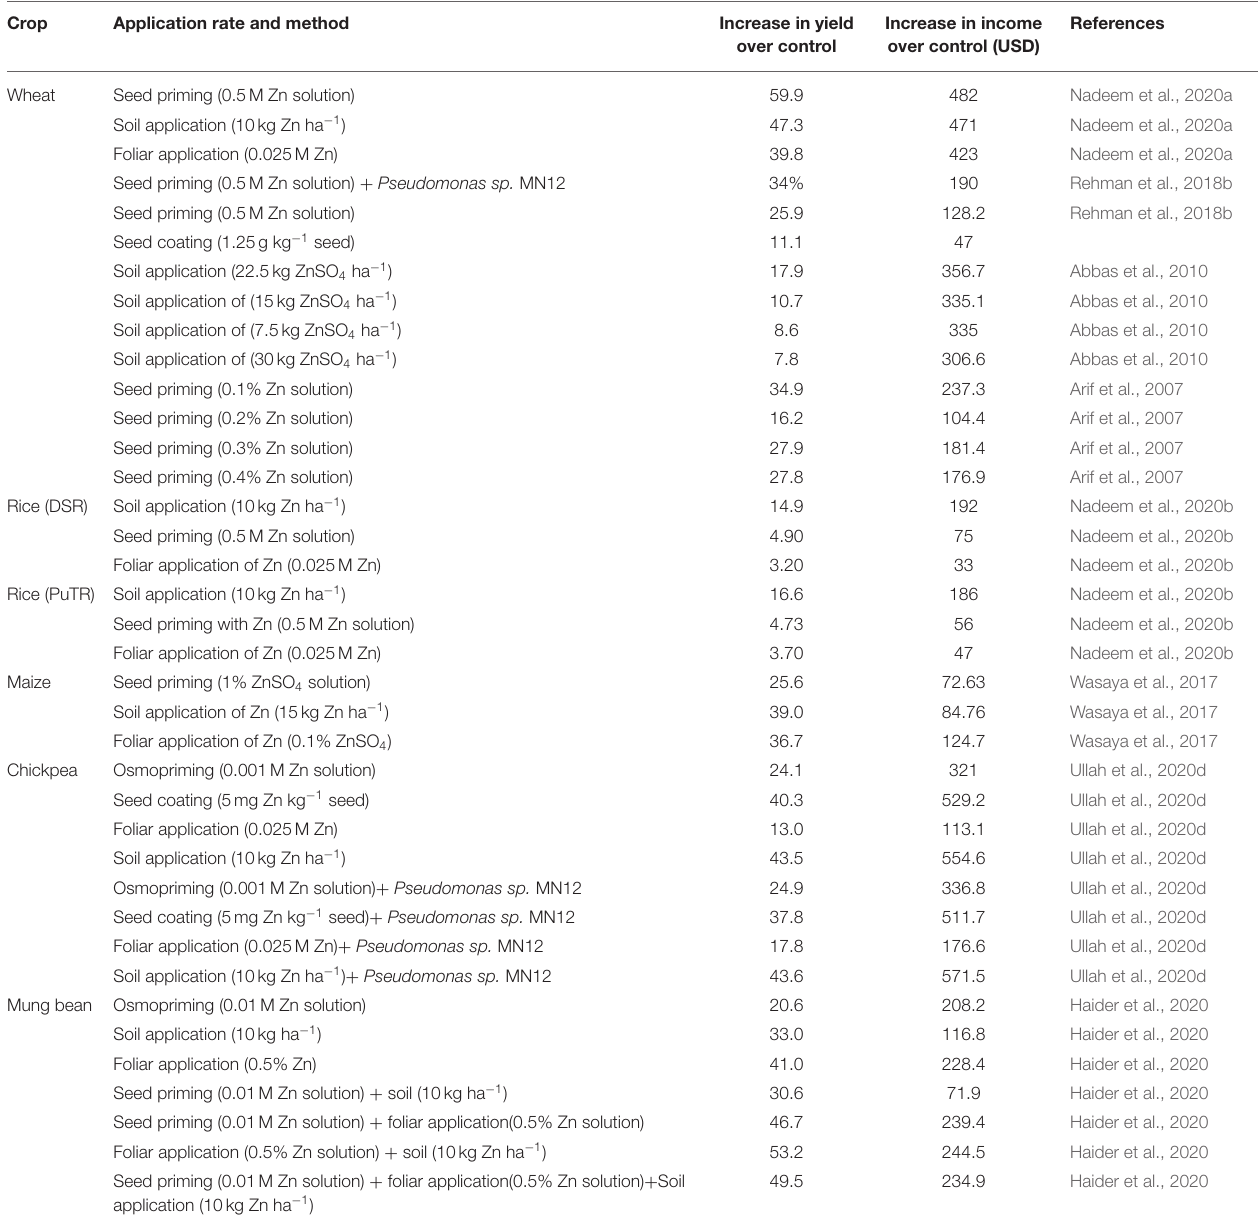
DSR, direct seeded aerobic rice; PuTR, Puddled transplanted